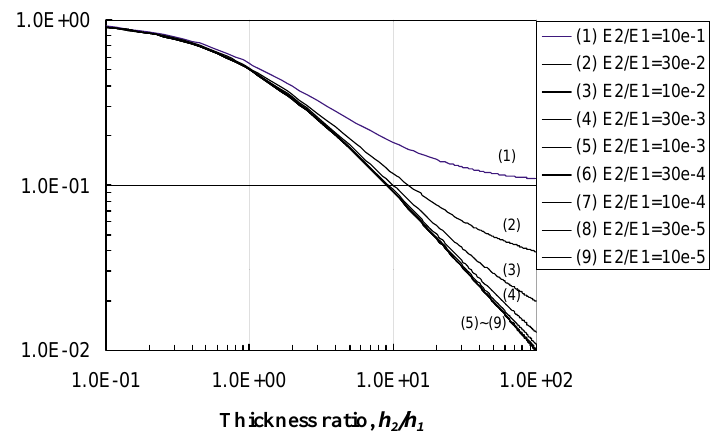
Fig. 3. Variation of relative effective modulus with thickness ratio.